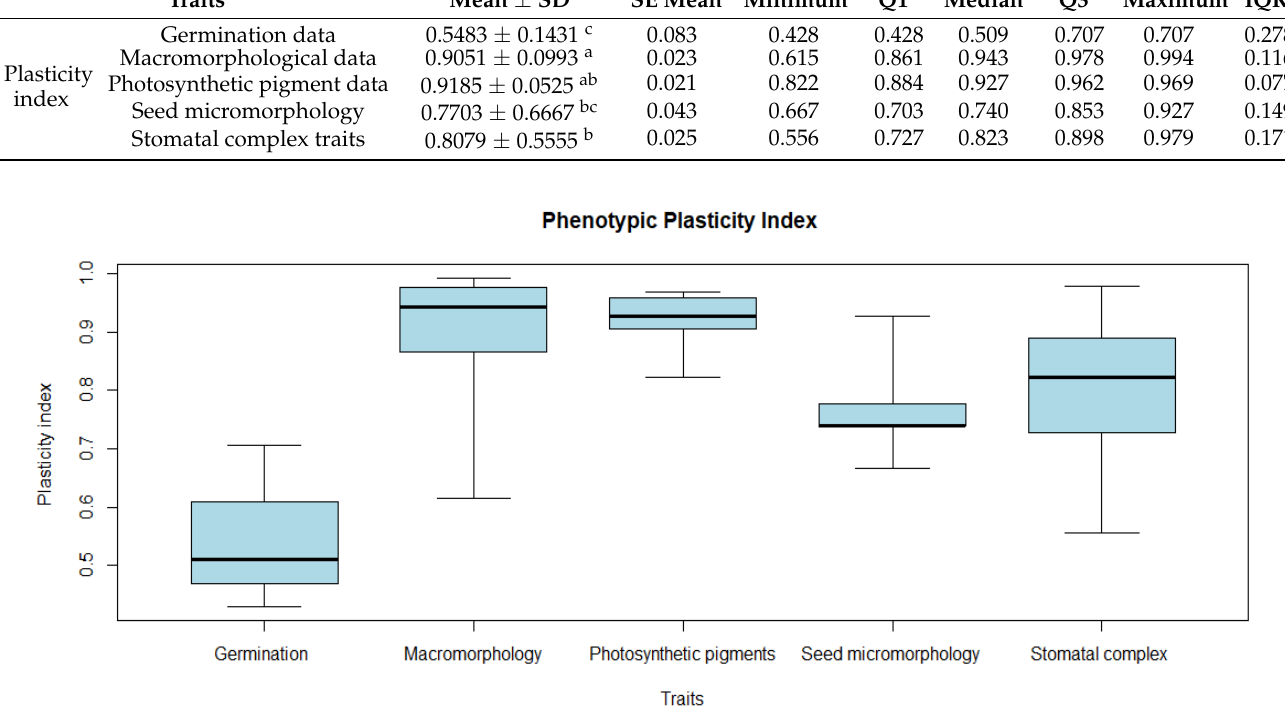
Figure 6. Boxplots showing phenotypic plasticity index (PI) distribution for each of the measured traits along samples of Trianthema portulacastrum .